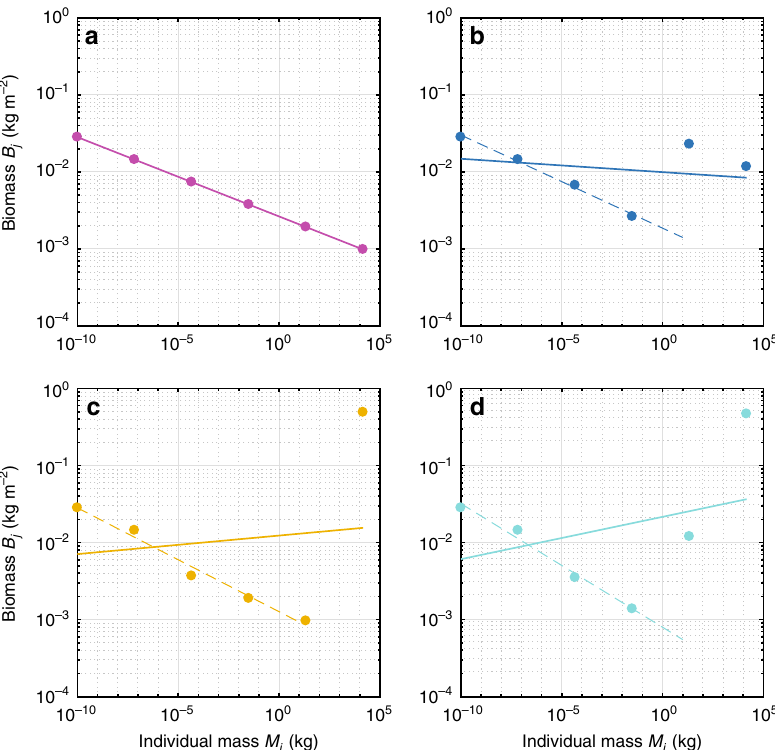
Fig. 2 Biomass distribution across trophic compartments for size-structured food webs. Biomass versus individual organism size for a base case, b LGPs, c GSCs, and d LGPs + GSCs. Dashed line in each plot represents the slope of the biomass spectrum including only trophic compartments up to the fi sh